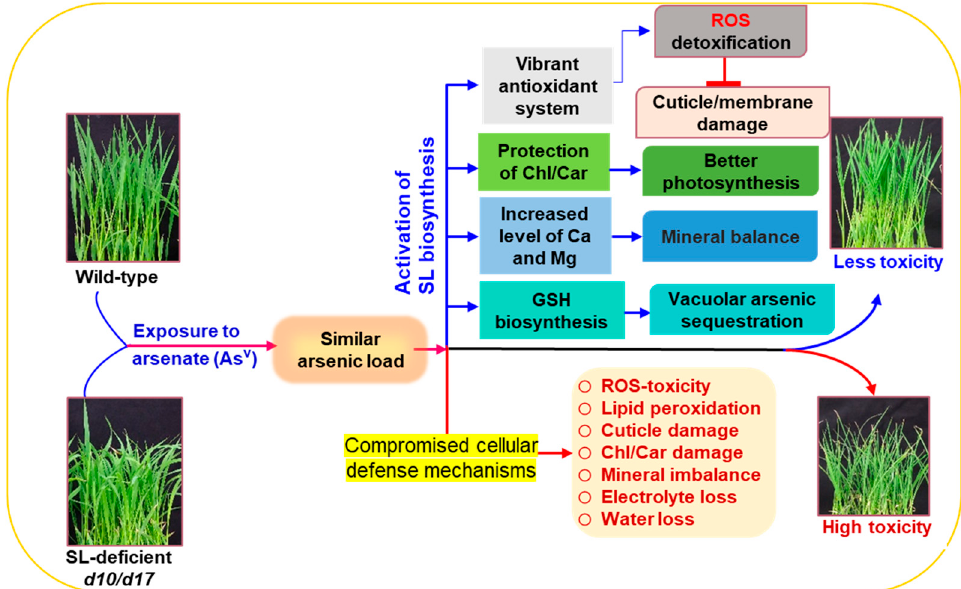
Figure 7. Illustration of strigolactones (SLs)-mediated resistance mechanisms against arsenate toxicity in the shoots of rice plants. Exposure of wild-type (WT) and SL-depleted d10 and d17 mutants to arsenate (As V ) stress resulted in a similar level of arsenic in the shoots of both WT and SL-deficient mutant genotypes. Despite having similar levels of arsenic in the shoots, SL mutants suffered severe As V toxicity because of compromised cellular defense mechanisms. On the other hand, As V stress-activated SL biosynthesis (e.g., As V -induced expression of D10 and D17 ) in WT shoots, leading to stimulation of several cellular defense strategies, which helped WT plants to reduce As V toxicity and perform better under excessive As V stress.